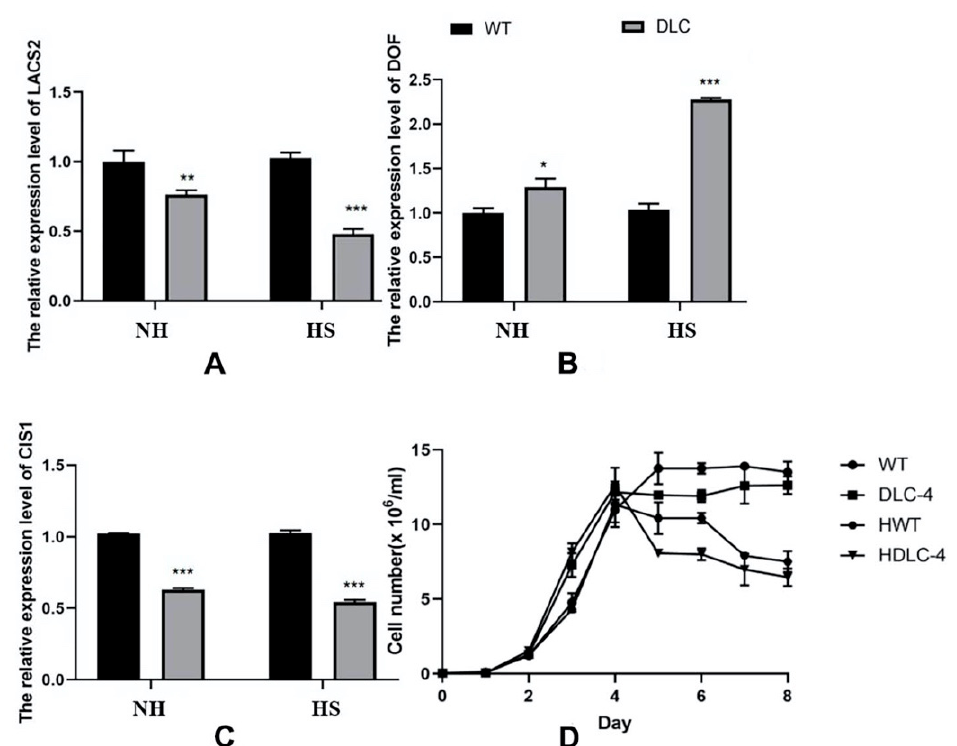
Figure 1. The mRNA expression patterns of crdof, cracs2, and cis1 in the DLC-4 and WT when strains were treated with HS (HS) and without HS (NH). ( A ) The expression levels of LACS2. ( B ) The expression levels of DOF. ( C ) The expression levels of CIS1. Statistical significance (one-way ANOVA) is represented by asterisks (*, **, and *** indicate a difference at p ≤ 0.05, p ≤ 0.01. and p ≤ 0.005, respectively). ( D ) Growth curves of the DLC-4 and WT treated with heat shock (HDLC-4 and HWT) or without heat shock (DLC-4 and WT) at the mid-log phase. Error bars depict SD.